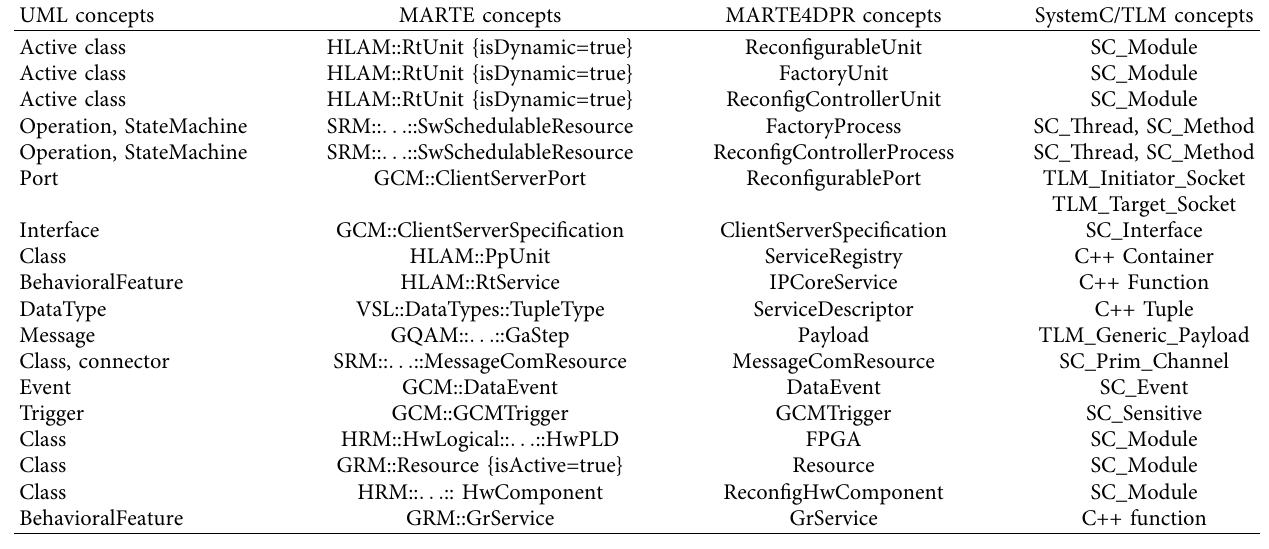
Table 4: Concept mapping.